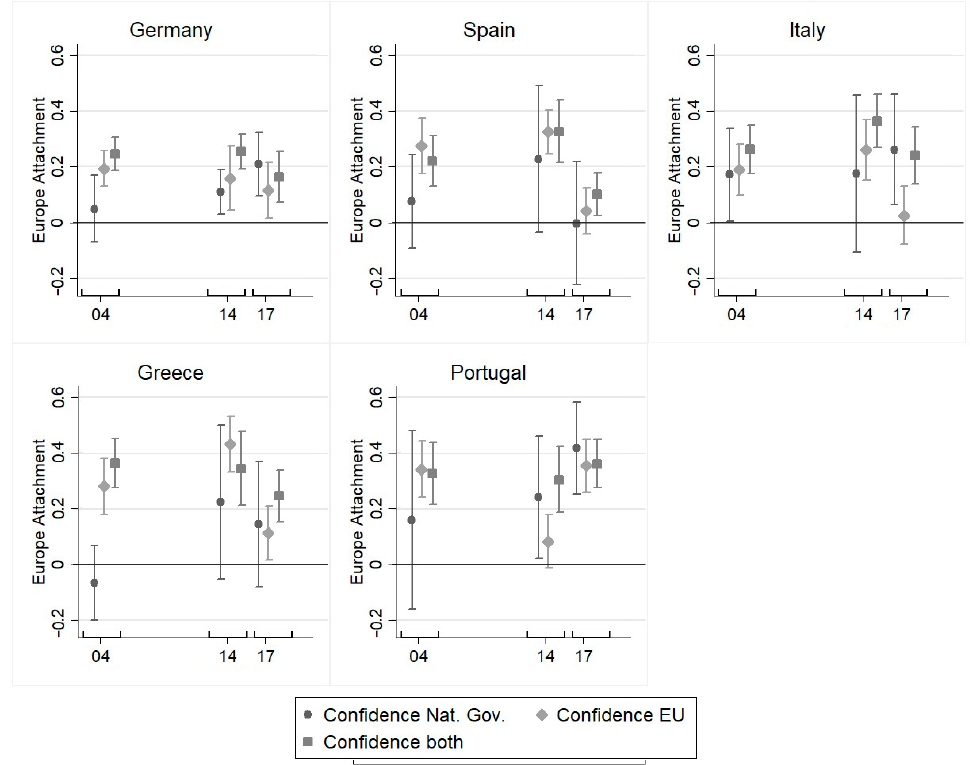
Figure 5. AMEs of the confidence in national government, the EU and both (with respect to confidence in neither) in the probability of attachment to Europe by year, with 95% CIs. Source: Own elaboration from Eurobarometer.